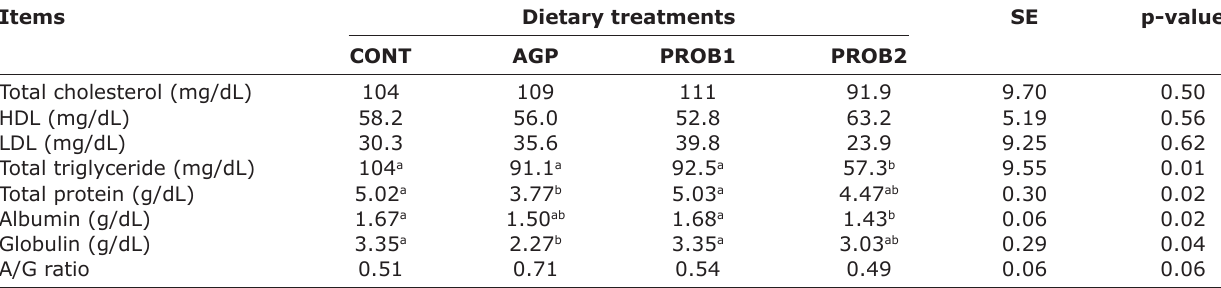
Table-6: Effect of multi-strain probiotic preparation in combination with vitamins and minerals on serum biochemical parameters of the Indonesian indigenous crossbred chickens. Items Dietary treatments